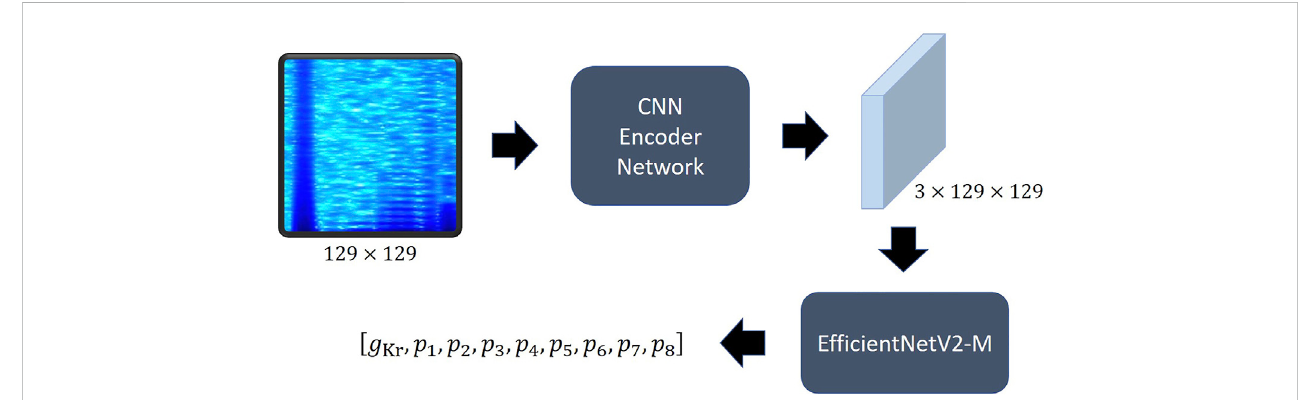
FIGURE 5 The structure of hERGNet. The spectrogram of current is converted into 2D data with three channels like the image shape through the CNN encoder, making it possible to utilize the pretrained Ef fi